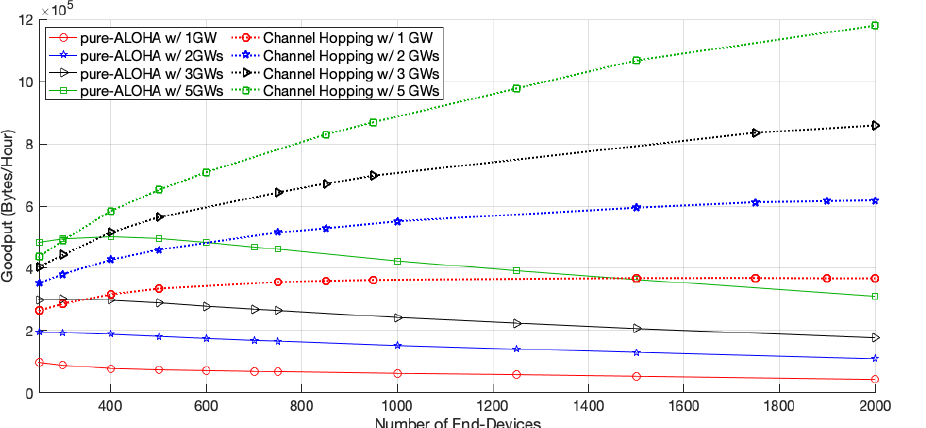
Figure 4. Network